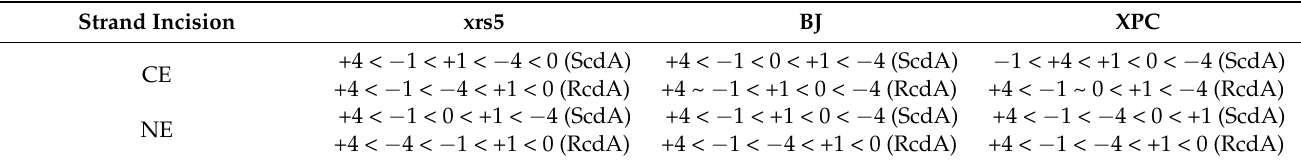
Table 2. The general trends of endonucleolytic activity observed after 1 min of reaction time for oligonucleotides containing ds-CDL (shown in Figure 2 and Table S1) treated with cytoplasmic extracts (CE) obtained from three cell lines (raw numerical data is presented in Supplementary Materials in Tables S6–S11) and with nuclear extracts (NE) obtained from three cell lines in previous studies [8,32]. Frames indicate substrates with incision efficiency higher than for corresponding Control 1 (Table 1 and